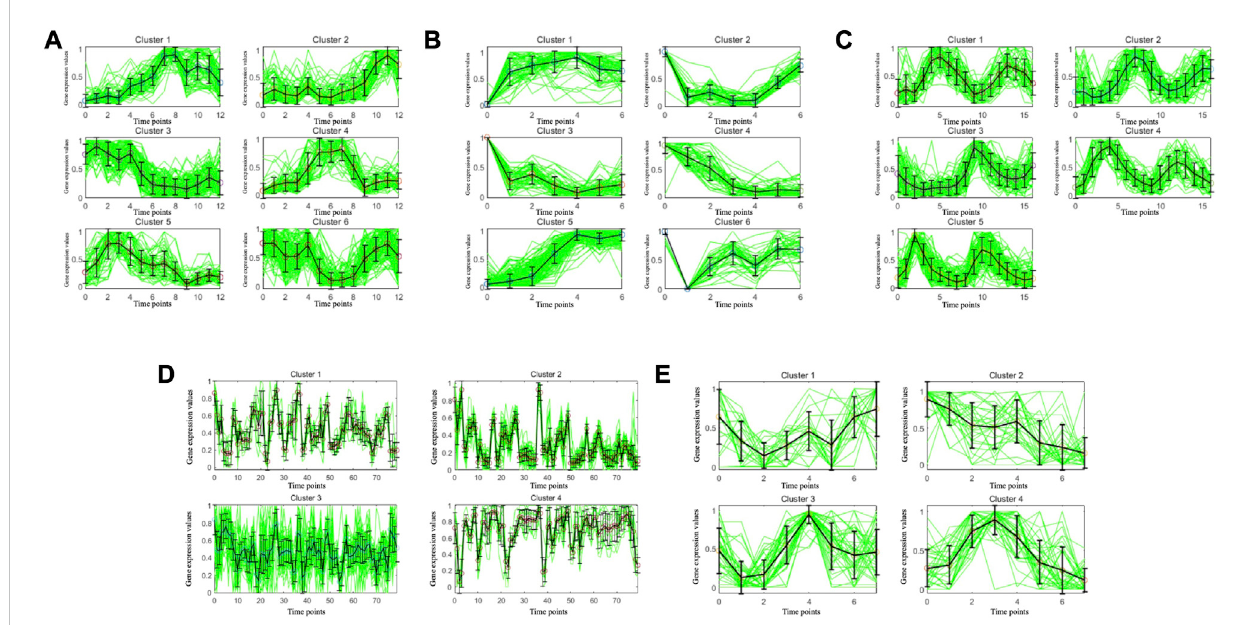
FIGURE 6 Cluster pro fi le plots of thegeneclusters obtianed by MSC-CSMC. (A) YeastGalactose Metabolism withthenumberof constraints s =5 (B) YeastCell Cyclewiththenumberofconstraints s =10 (C) YeastSporulation withthenumberofconstraints s =15 (D) Serumwiththenumberofconstraints s =20 (E) Arabidopsis with the number of constraints s =25.